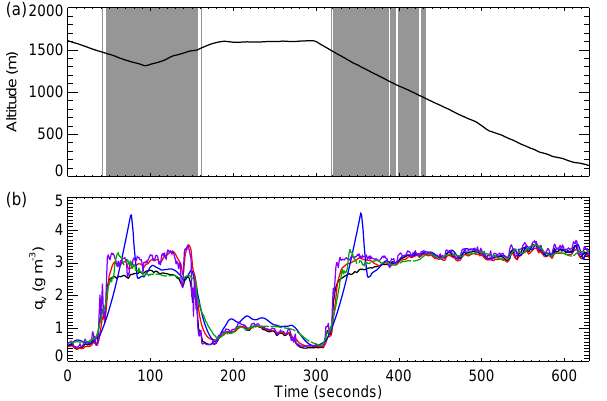
Figure 6. Time series from flight B582 showing penetrations of liquid cloud (chilled mirror data omitted for clarity). Lower panel shows absolute humidity from the wvssF (black), wvssR (red) and wvssF + CDP liquid water content (green). Upper panel shows liq- uid water content (black) and mean volume radius (red) derived from the